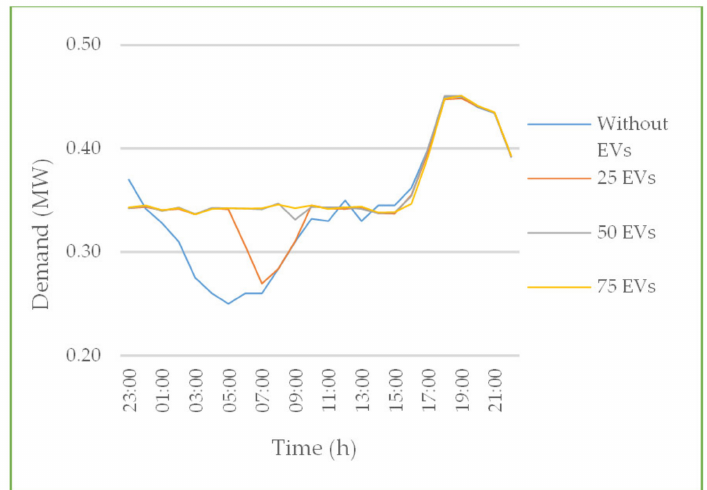
Figure 11. The effect of charging/discharging on LC1 when N cars have a custom mobility pattern for valley filling and random EV mobility pattern for peak shaving: N = 25, 50 and 75 .